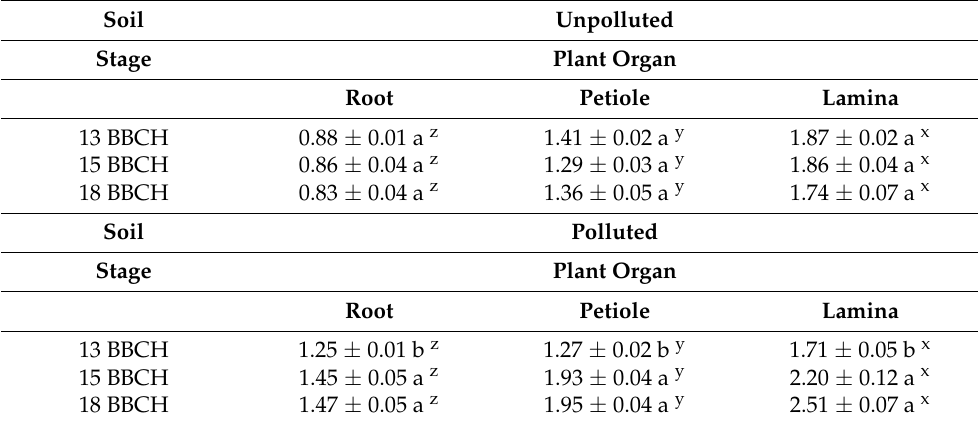
Table 12. Free proline content in different organs and developmental stages of S. perfoliatum plants grown in Ps and Us.